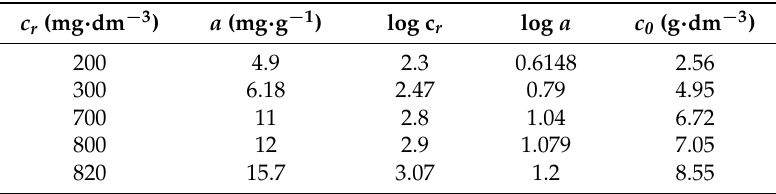
Table 7. Obtained experimental parameters.